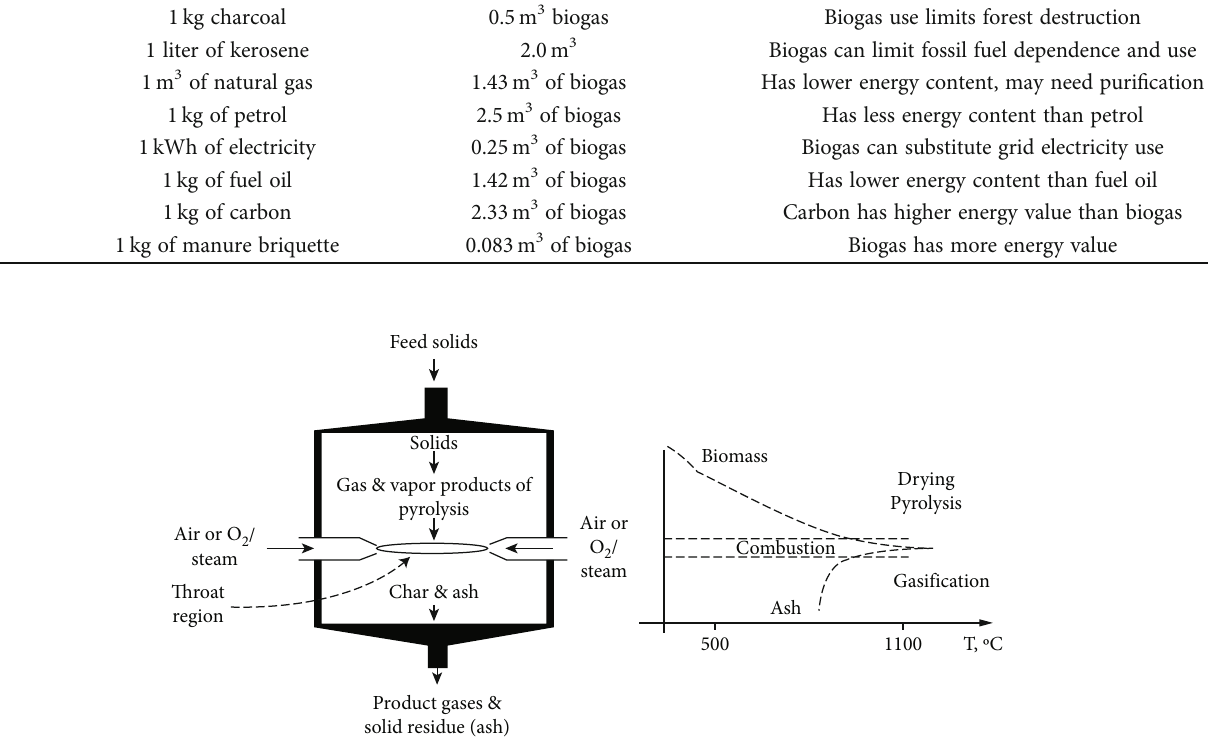
Figure 6: Thermal gasi fi cation of biomass [21, 126]. Table 8: Well-to-wheel (WTW) GHG emissions in gCO